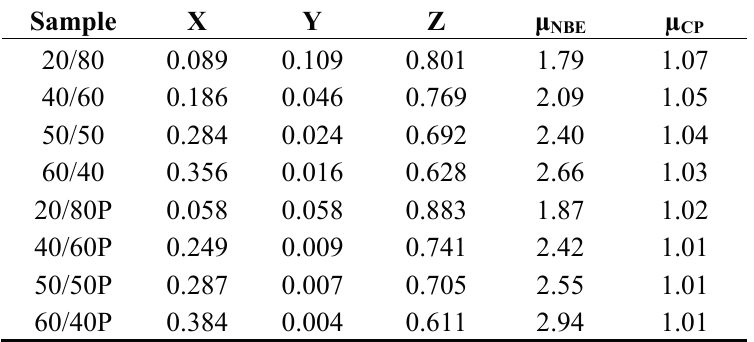
Table 4. Dyad monomer sequences X = M NBE -M NBE , Y = M CP -M CP , Z = M NBE -M CP dyads and mean sequence